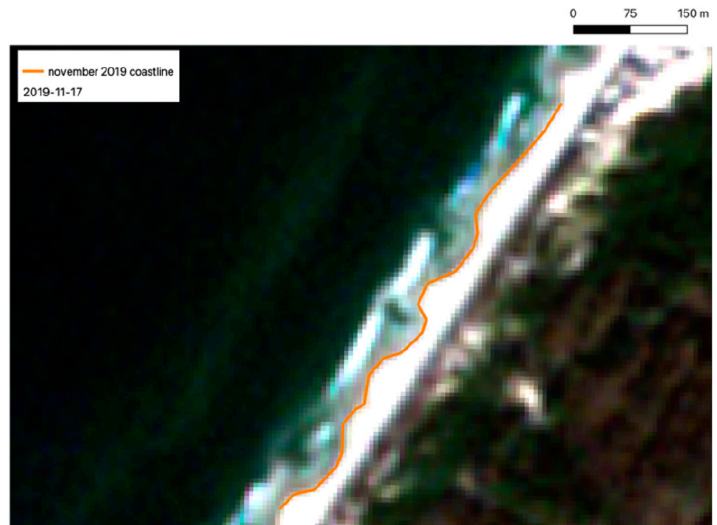
Figure 3. Example of visual shoreline detection based on satellite image.